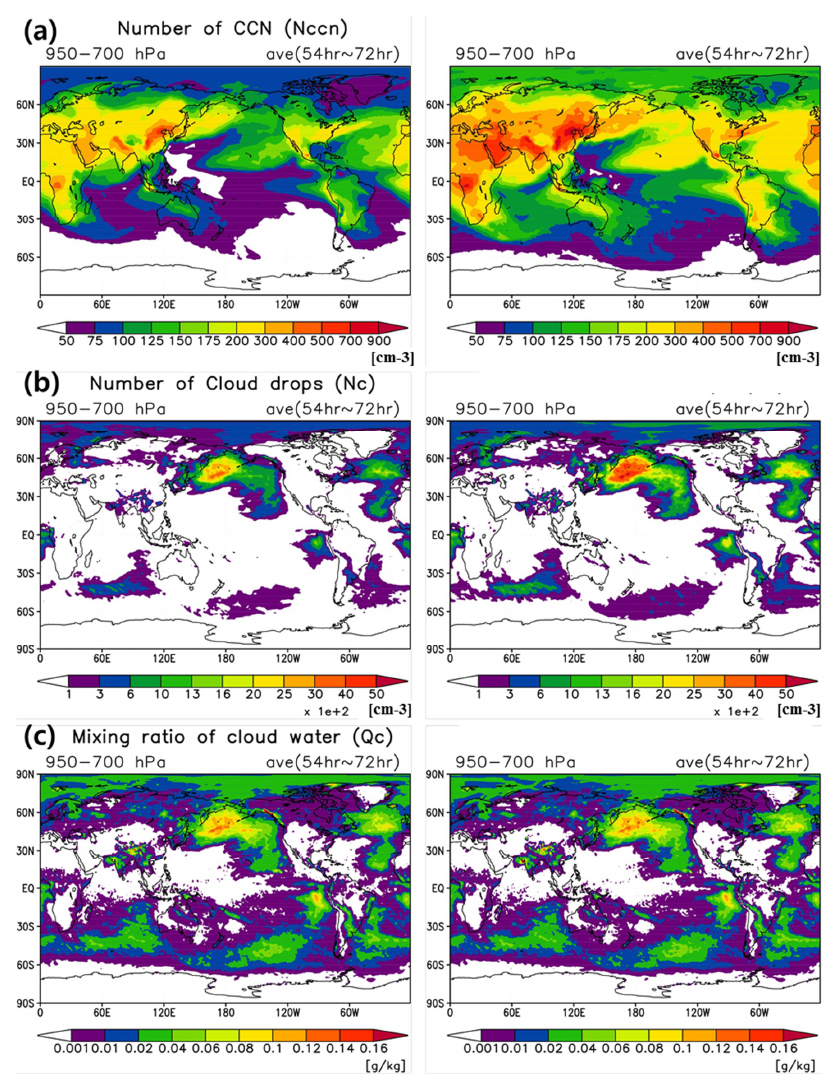
Figure A1. Number concentrations of ( a ) CCN, ( b ) cloud droplets, and ( c ) mixing ratio of cloud water for the GRIMs simulations with ( left panel ) original and ( right panel ) doubled aerosol concentrations.